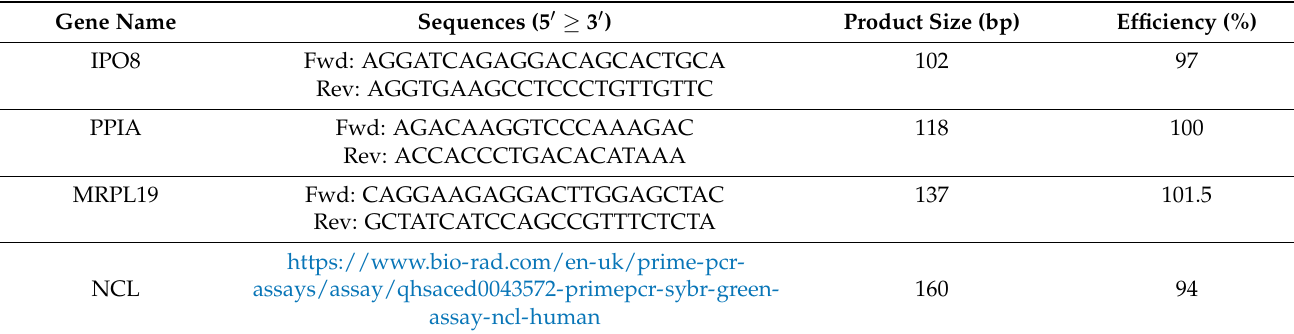
Table A1. Primer sequences used in